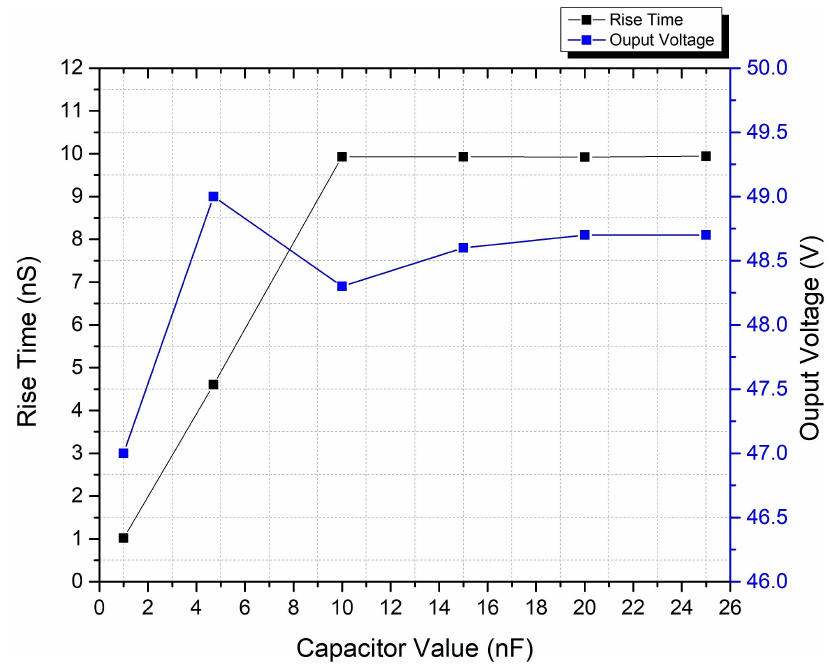
Figure 10. The transient response of the modified Marx generator circuit without the optocoupler. As shown in Figure 10, the rise time initially increased to a value of 9.93 ns with an increase in the capacitance value, but after that the rise time was constant. It is clear from Figure 10 that the output voltage varied in same manner as it varied in Figure 10. The addition of the optocoupler helps with the fast discharge of the capacitor due to the improved isolation between two parallel